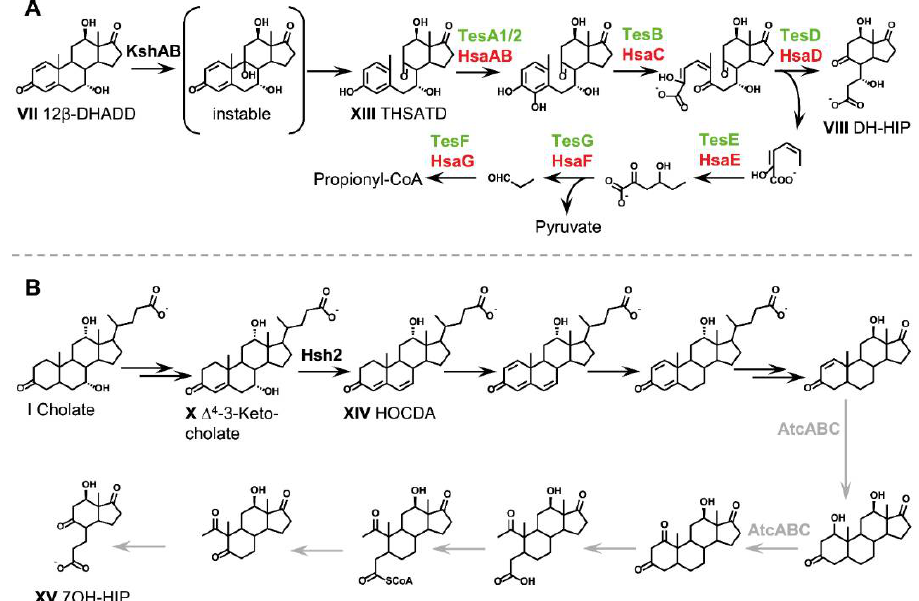
Figure 5. Cleavage of rings A and B as well as degradation of the A-ring as phase 3 of bacterial bile acid degradation. ( A ) Aerobic degradation via the 9,10- seco pathway. Text colors indicate the organism, in which the respective enzyme has been identified: dark blue, P. stutzeri Chol1; light blue, P. putida DOC21; green, C. testosteroni TA441; red, R. jostii RHA1; magenta, Sphingobium sp. strain Chol11; black, identified in several organisms. ( B ) Anaerobic degradation via the 2,3- seco pathway. Colors: black, described for Azoarocus sp. strain Aa7; grey, as inferred from anaerobic degradation of cholesterol and testosterone. For bile acids, the respective deprotonated bile salts are depicted. Abbreviations: HOCDA, 12 α -Hydroxy-3-oxo-4,6-choldienoic acid; 7OH-HIP, 7-Hydroxy-H-methyl-hexahydro-indanone-propanoate.